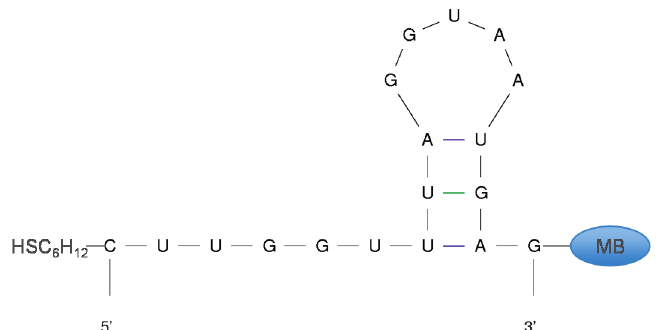
Figure 2. Secondary structure predictions for the parent sequence suggests an internal loop that can potentially keep the redox label (MB—methylene blue) distal from the electrode surface. The introduction of tobramycin forces the aptamer to fold bringing the methylene blue close to the 5'-terminus. The lowest energy secondary structure prediction is calculated using MFOLD [37,38]. This prediction was based on the parent aptamer in a 1 M NaCl solution at 25 °C and has a folding energy of − 0.66 kcal/mol.